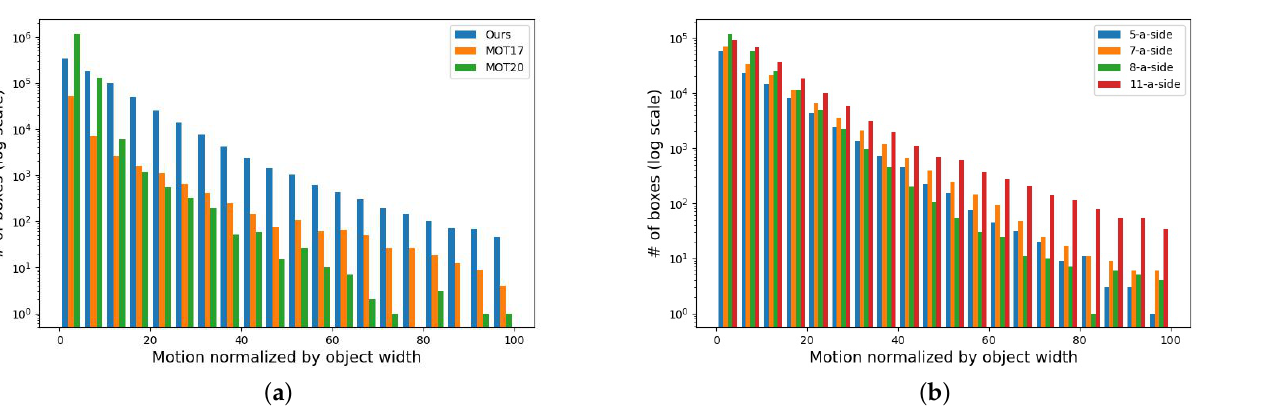
Figure 5. This two subfigures show distance between center of objects between two consecutive annotated frames. ( a ) Comparison between our dataset and MOTChallenge dataset. ( b ) Comparison between subdatasets of our